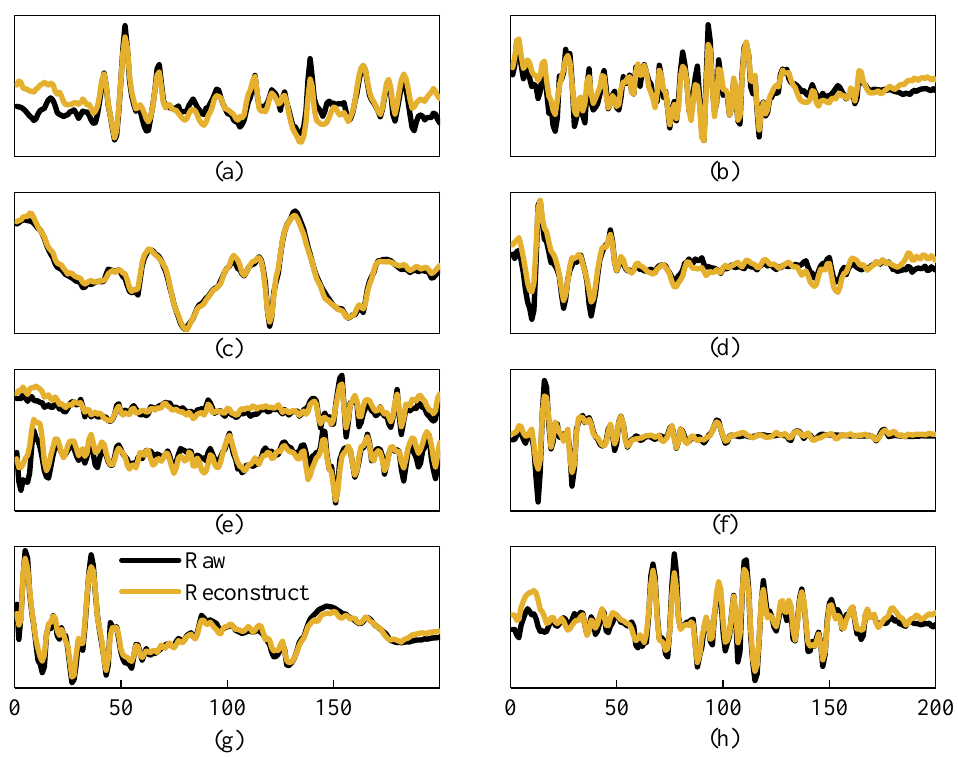
Figure 8. The raw and the reconstruction sEMG signals of the nine muscles. On the horizontal axis is time and on the vertical axis is myoelectric amplitude. ( a ) Rectus Femoris; ( b ) Vastus Medial; ( c ) Vas- tus Lateralis; ( d ) Tibialis Anterior; ( e ) Soleus and Semitendinosus; ( f ) Biceps Femoris; ( g ) Medial Gastrocnemius; ( h ) Lateral Gastrocnemius.